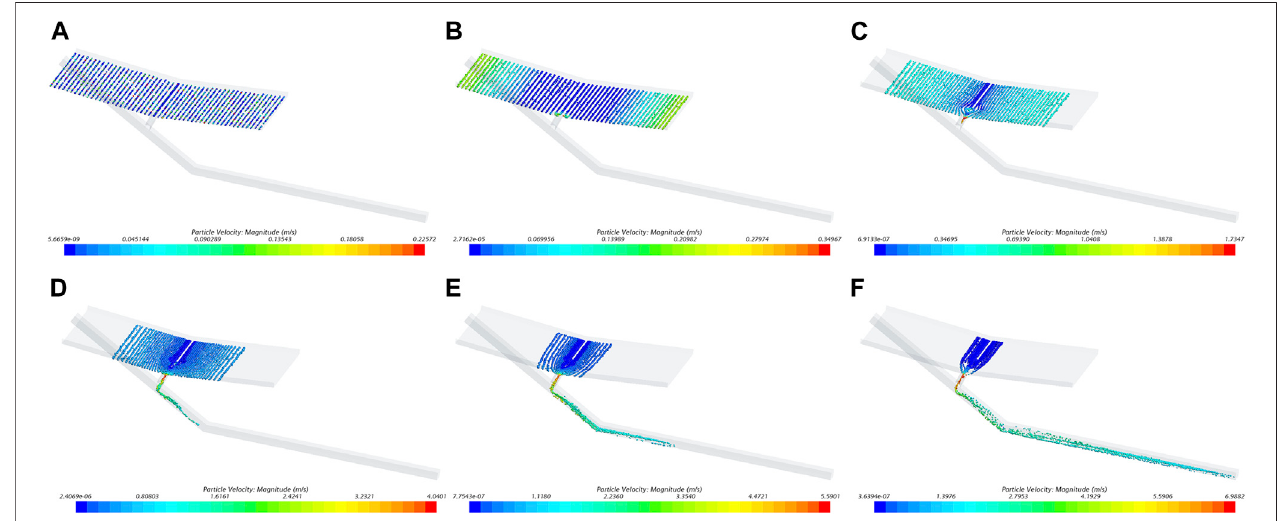
Frontiers in Earth Science |